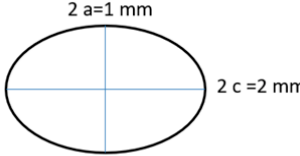
Figure 2. Dimensions of the internal elliptical defect.